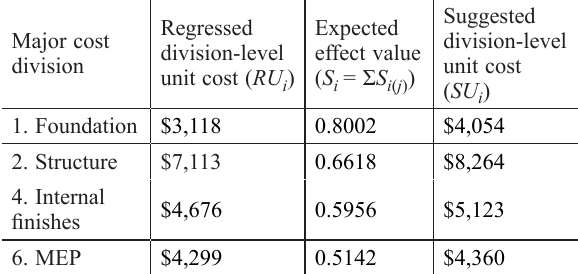
Table 6. Regressed and suggested division-level unit costs for the four major cost divisions in project I Major cost division